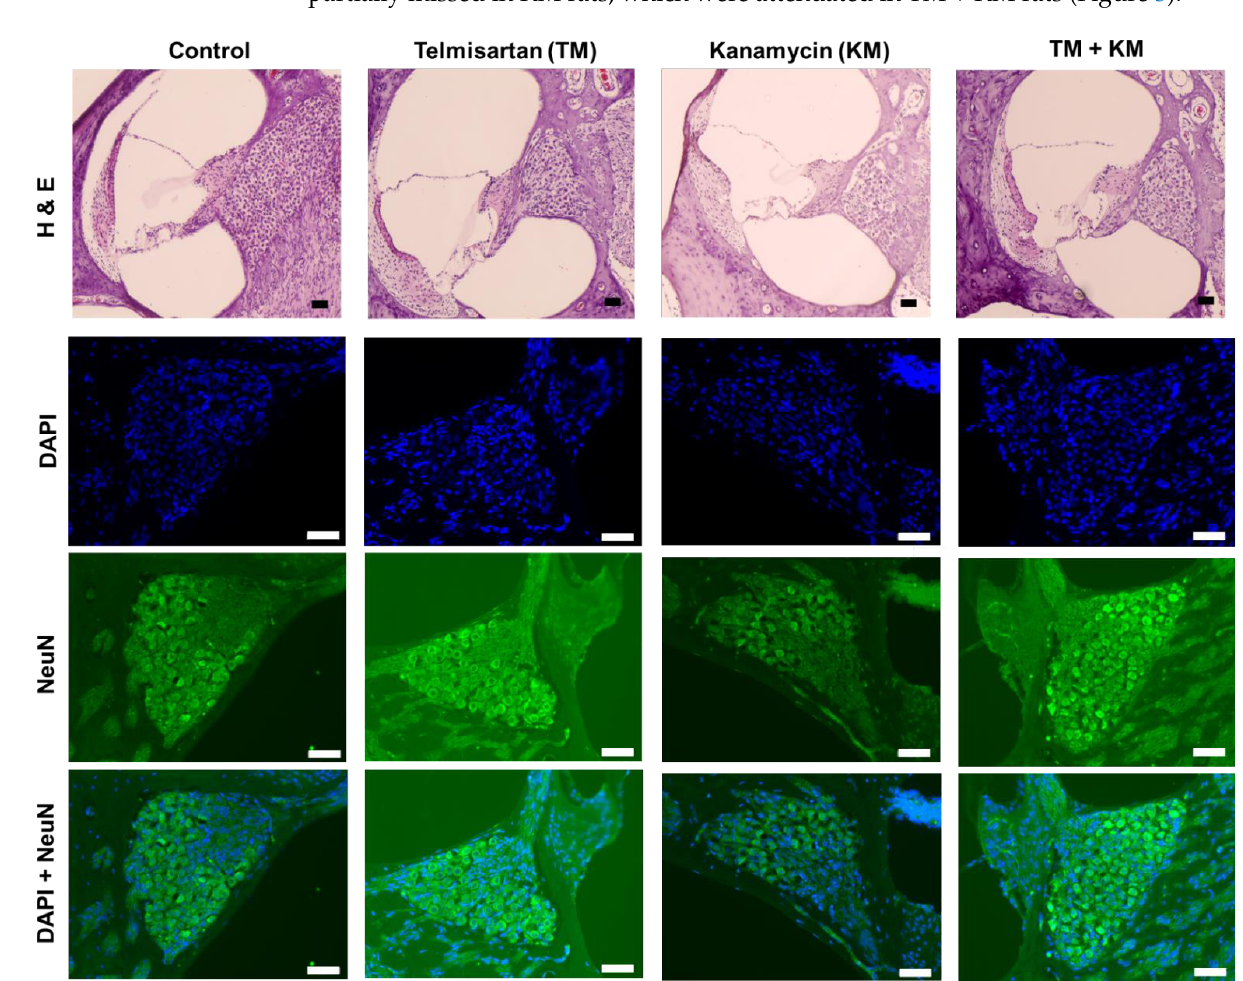
Figure 2. Hematoxylin and eosin (H&E) staining of the cochlea and immunofluorescence staining (Green: NeuN-positive cells; Blue: DAPI-positive cells). The KM + KM group showed smaller changes in the loss of spiral ganglion cells than the KM group, scale bar: 50 um.